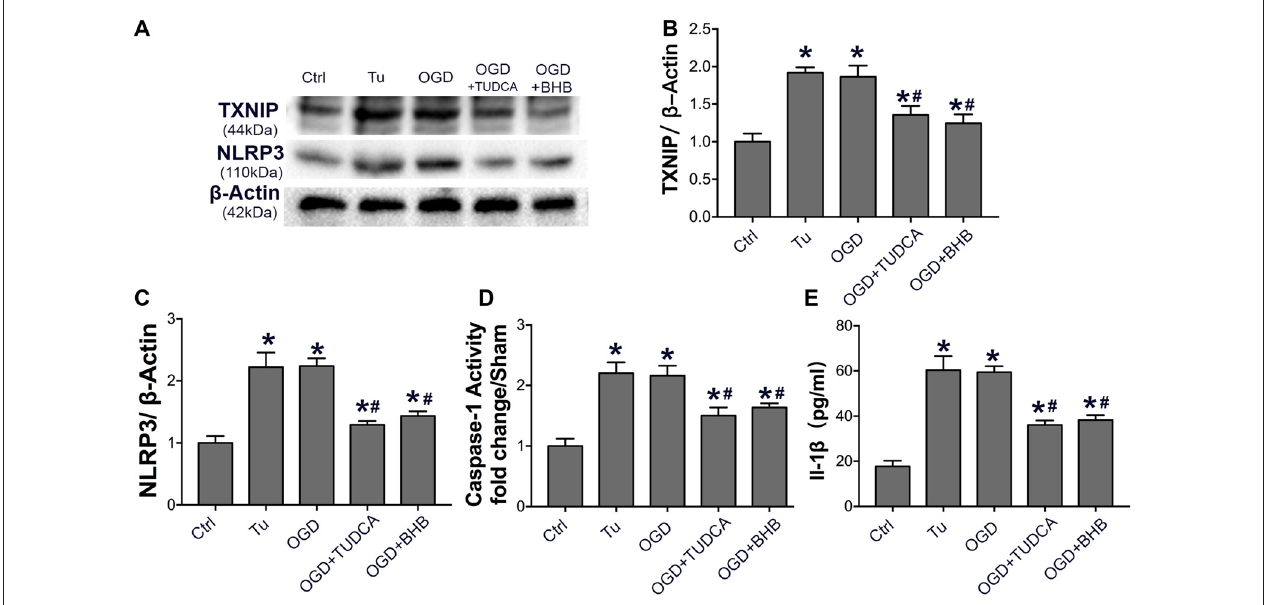
FIGURE 9 | BHB and endoplasmic reticulum (ER) stress inhibitor tauroursodeoxycholic acid (TUDCA) suppressed NLRP3 inflammasome after OGD/R. (A–C) Protein expression of TXNIP and NLRP3 was detected by Western blotting. Representative blots from six independent experiments with similar results are shown. (D) Caspase-1 activity was detected on cell lysates and compared to that in sham-operated mice. (E) IL-1 β concentration of culture medium. Data are shown as mean ± SEM; ∗ P < 0.01 vs. Ctrl group, # P < 0.05 vs. OGD group. Tu,